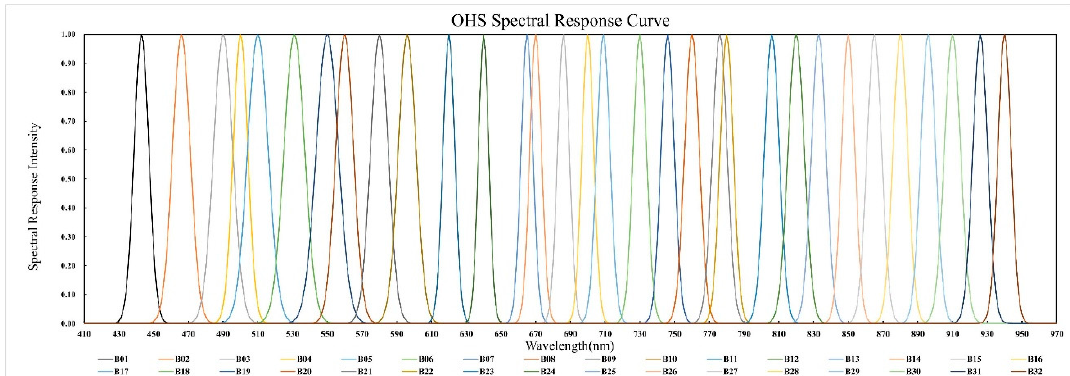
Figure 2. CMOS sensor spectrum distribution. Sensors 2020 , 20 , x FOR PEER REVIEW